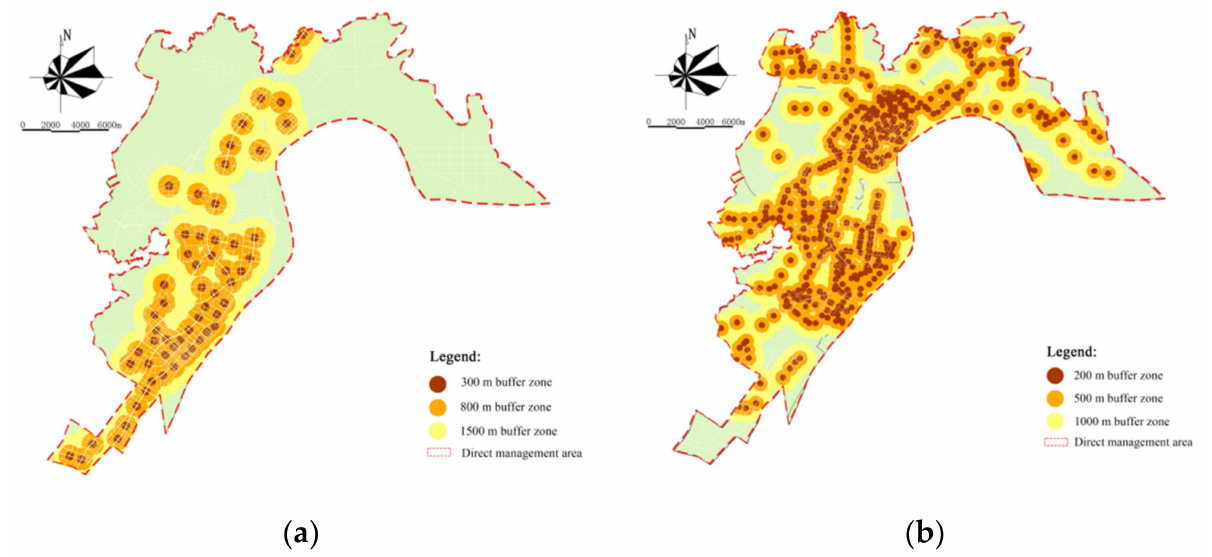
Figure 5. ( a ) Multi-ring buffer zone analysis of rail transit; ( b ) Multi-ring buffer zone analysis of bus